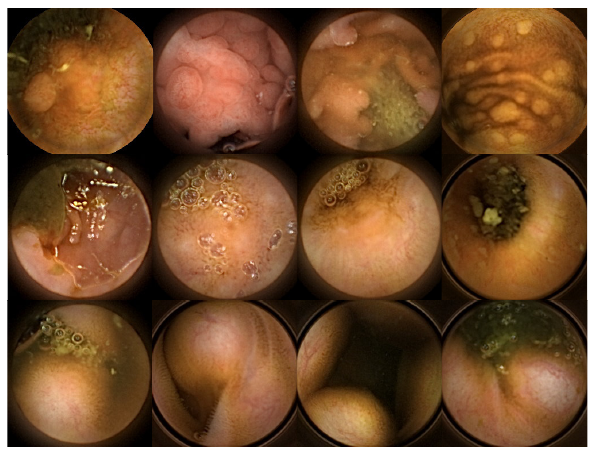
Figure 3. Protrusion lesions of different types in different parts of the digestive tract used for our proposed method. The first row is polyps in different shapes and numbers. The next row is lymphoid hyperplasias and the final is submucosal eminence. All are collectively referred to as protrusion lesions.